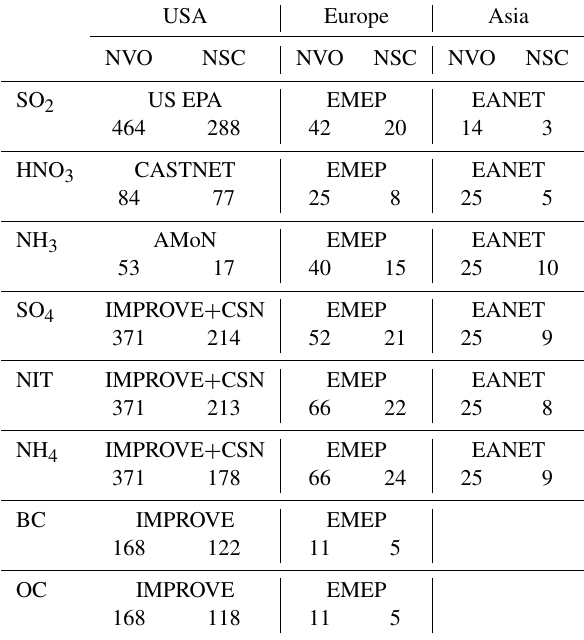
Table 2. Number of sites with surface concentration observation (NVO) and number of sites satisfying criterion (NSC) at surface monitoring networks in the US, Europe, and Asia.